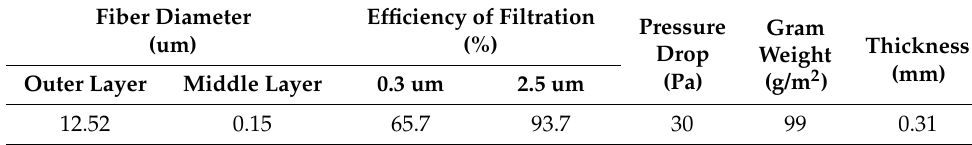
Table 4. Basic parameters of the